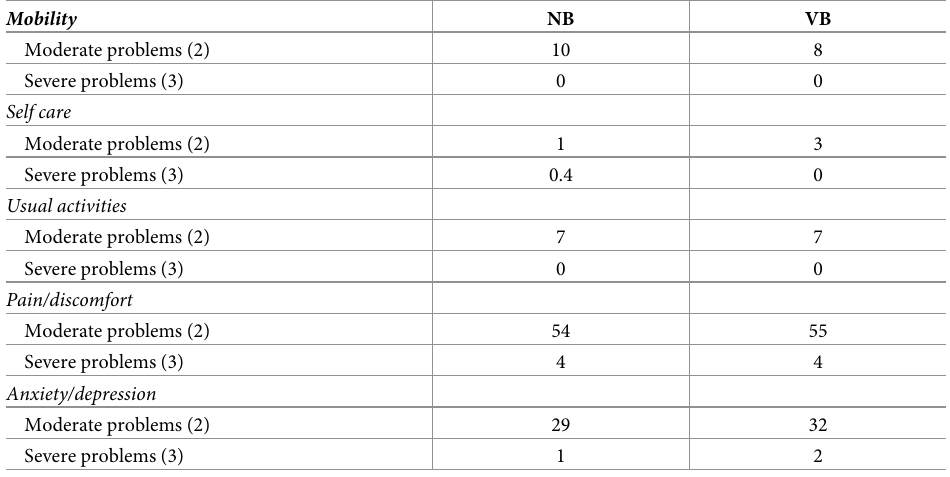
Table 4 presents the self-reported HRQoL and EQ-VAS for different age groups for the two counties. Table 3. Proportion respondents reporting moderate or severe problems on each EQ-5D dimension; %.